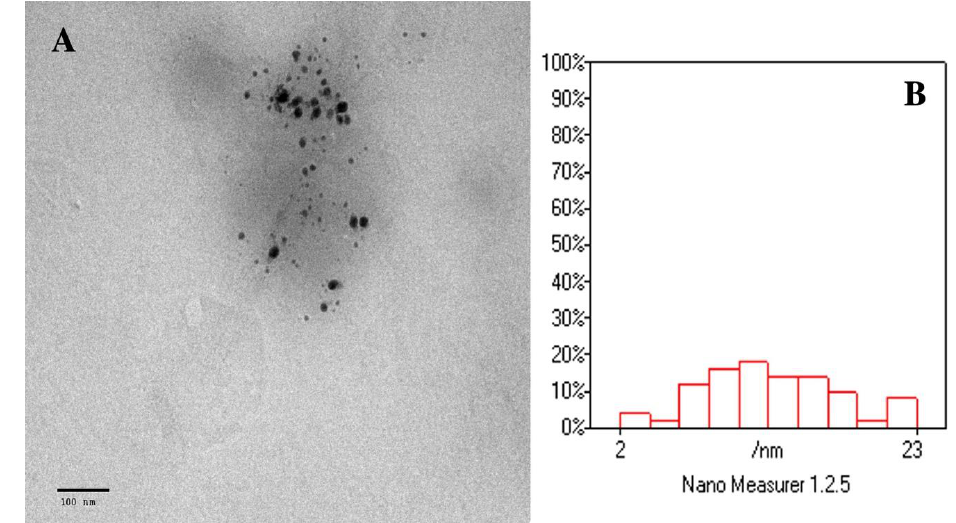
Figure 3. ( A ) TEM micrograph of total phenolics AgNPs of the flower. Mag. 120,000×; ( B ) TEM analysis using Nano Measurer software.